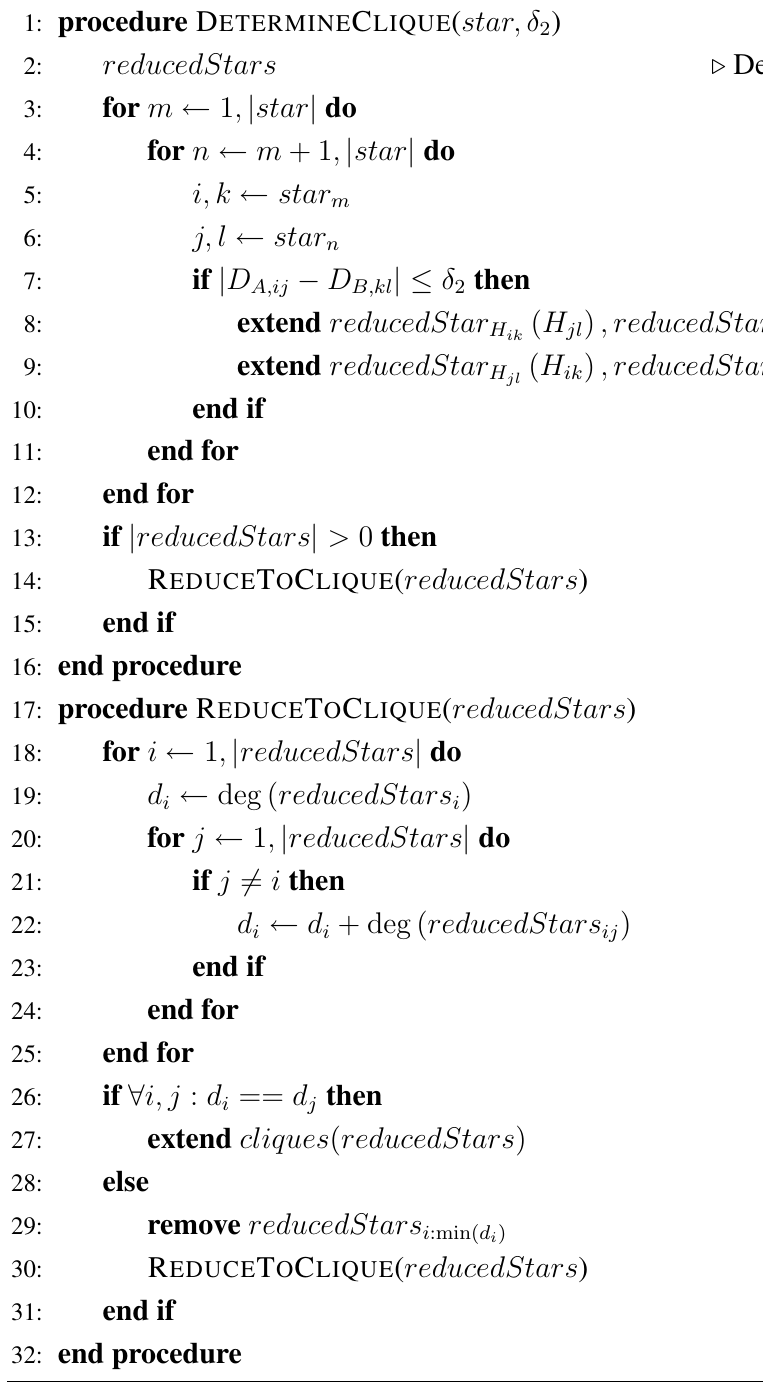
Algorithm 3 Determination of cliques. The non-central nodes of a previously determined star are central nodes of new stars ( reducedStars ) that have to be tested for fulfilment of the second distance condition (line 7). R EDUCE T O C LIQUE then recursively reduces the set of these stars to a